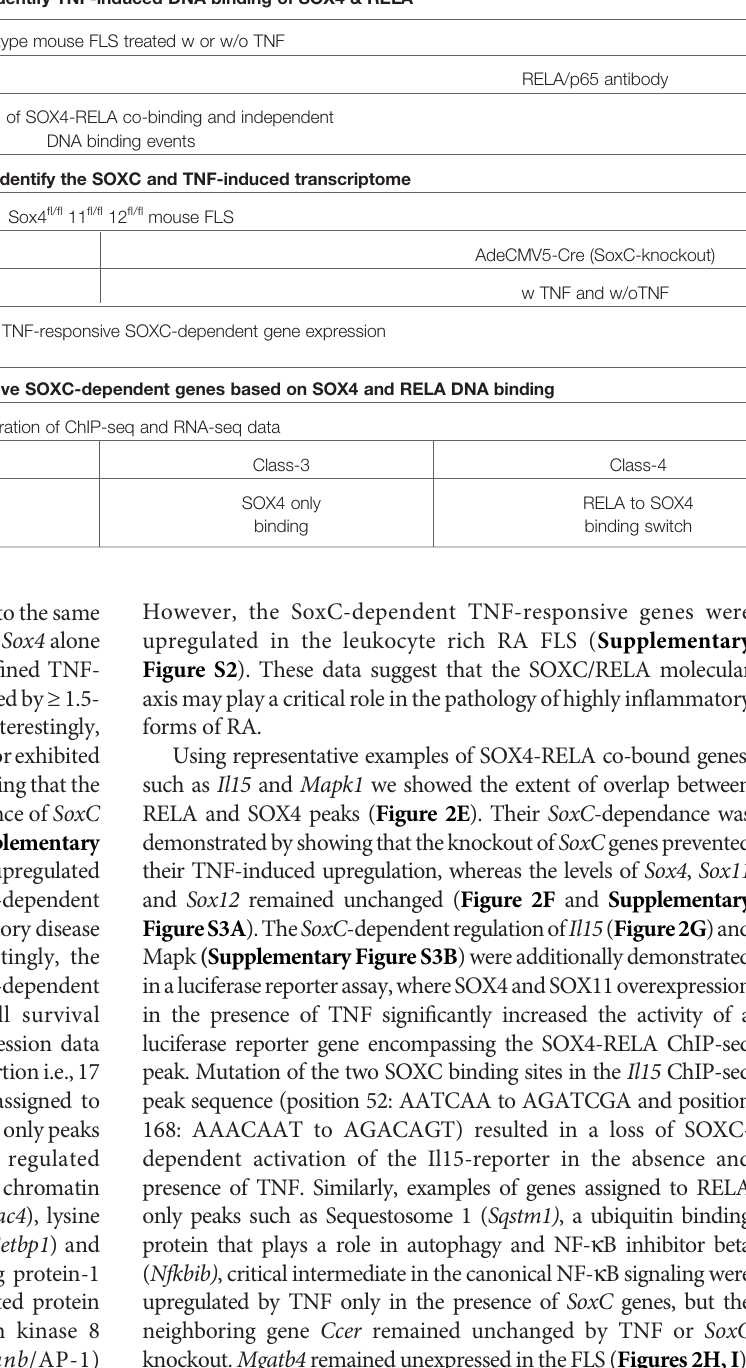
TABLE 1 | Conceptual design to study the molecular interactions between RELA and SOXC transcription factors. Step1: ChIP-seq to identify TNF-induced DNA binding of SOX4 & RELA Wild-type mouse FLS treated w or w/o